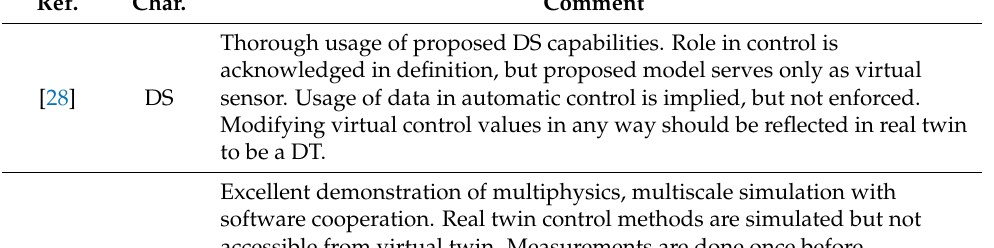
Table 2. Characterization of reviewed work regarding data flow automation definitions.